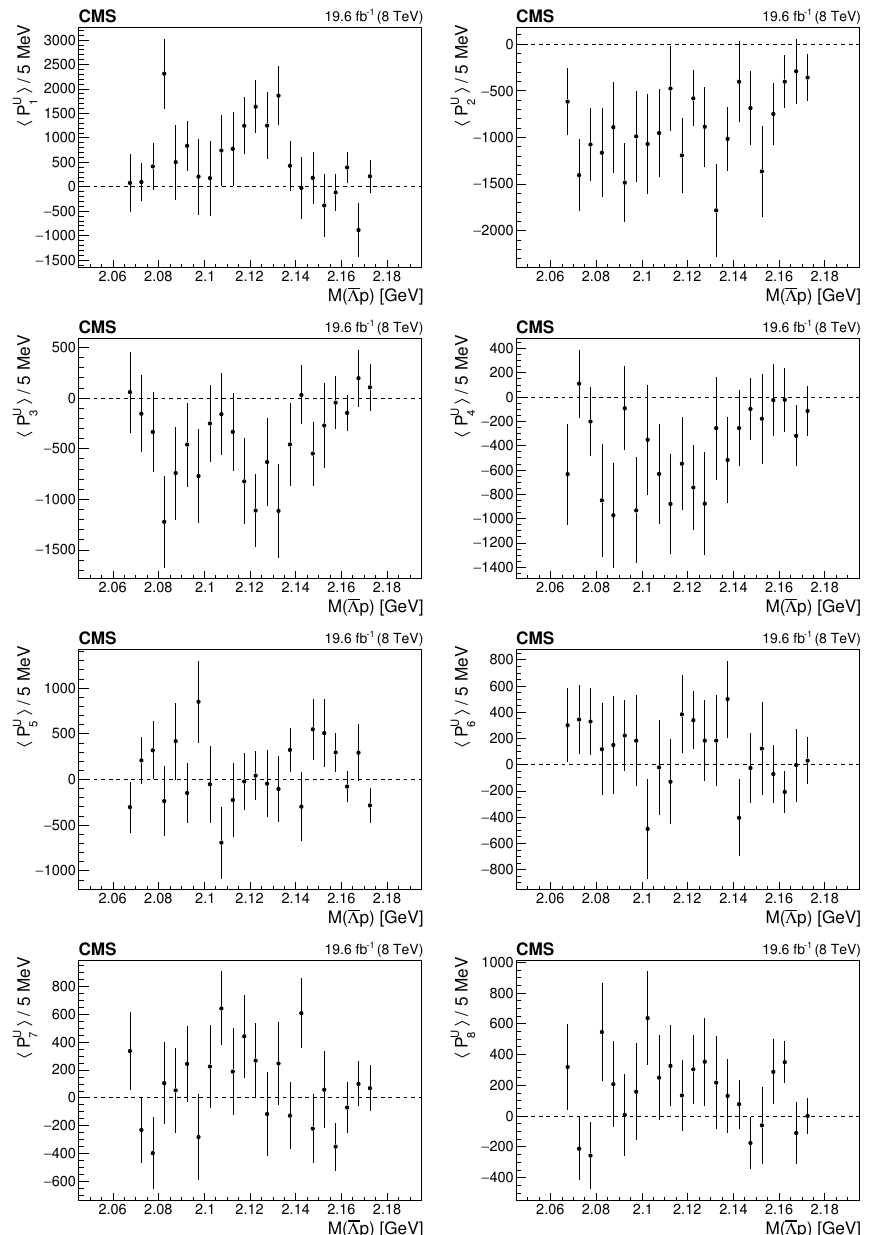
Figure 5 . The dependence of the (cid:12)rst eight Legendre moments on M ((cid:3)p). The vertical bars represent the statistical